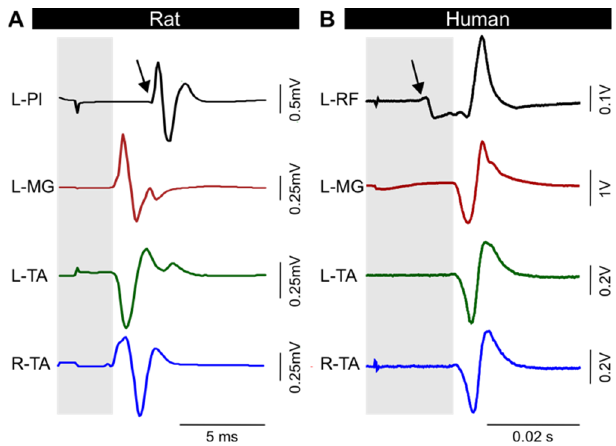
Figure 2. Transspinal evoked potential (TEP). Typical TEPs recorded from leg muscles in rat ( A ) and human ( B ). The response latency for ankle muscles (grey area) is different from muscle at other joints (arrow). L, left; R, right; Pl, plantar muscle; MG, medial gastrocnemius; TA, tibialis anterior; RF, rectus femoris.